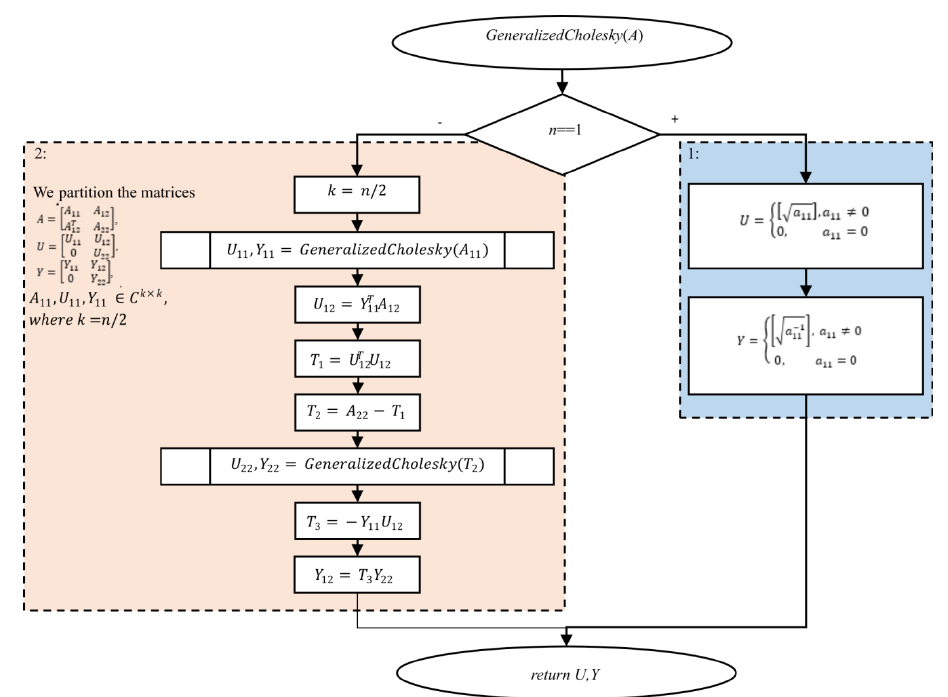
Figure 1. Algorithm 4.1 (Figure A1) Recursive generalized Cholesky factorization.